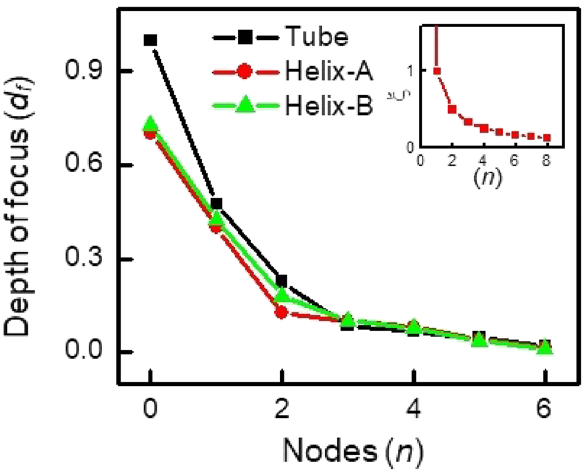
Figure 5. Variation of the depth of the focus of l -RMs with a node. Inset shows a variation of the coherence length with a